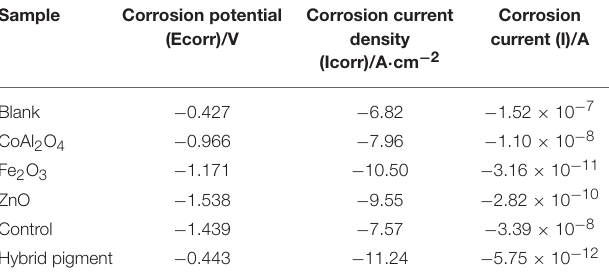
TABLE 5 | Tafel curve parameters of the anticorrosion coatings containing different pigments and blank sample.